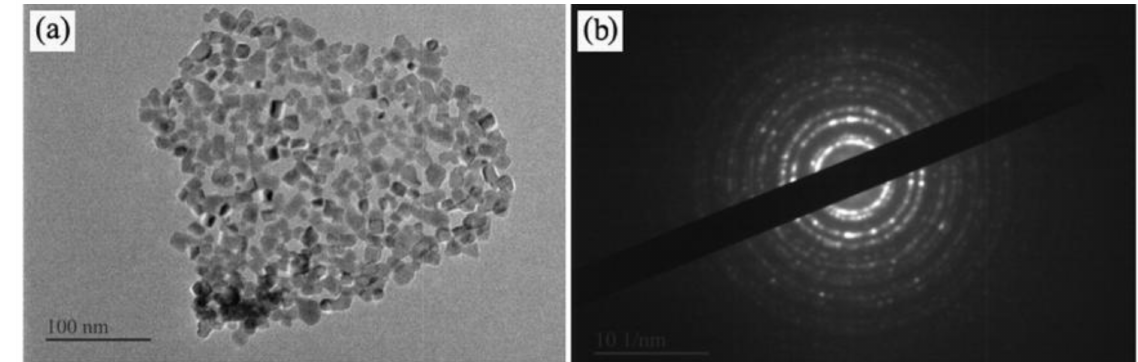
Figure 11. TEM images of the CeO 2 product prepared with (A/C = 1.5). ( a ) Typical TEM images; ( b ) SAED diffraction